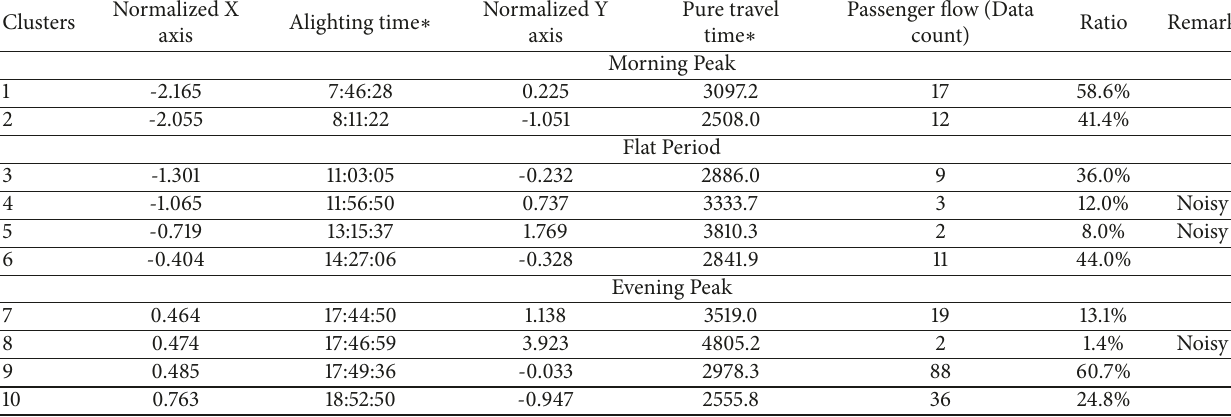
Table 4: Result of synchronous clustering algorithm (Sync).